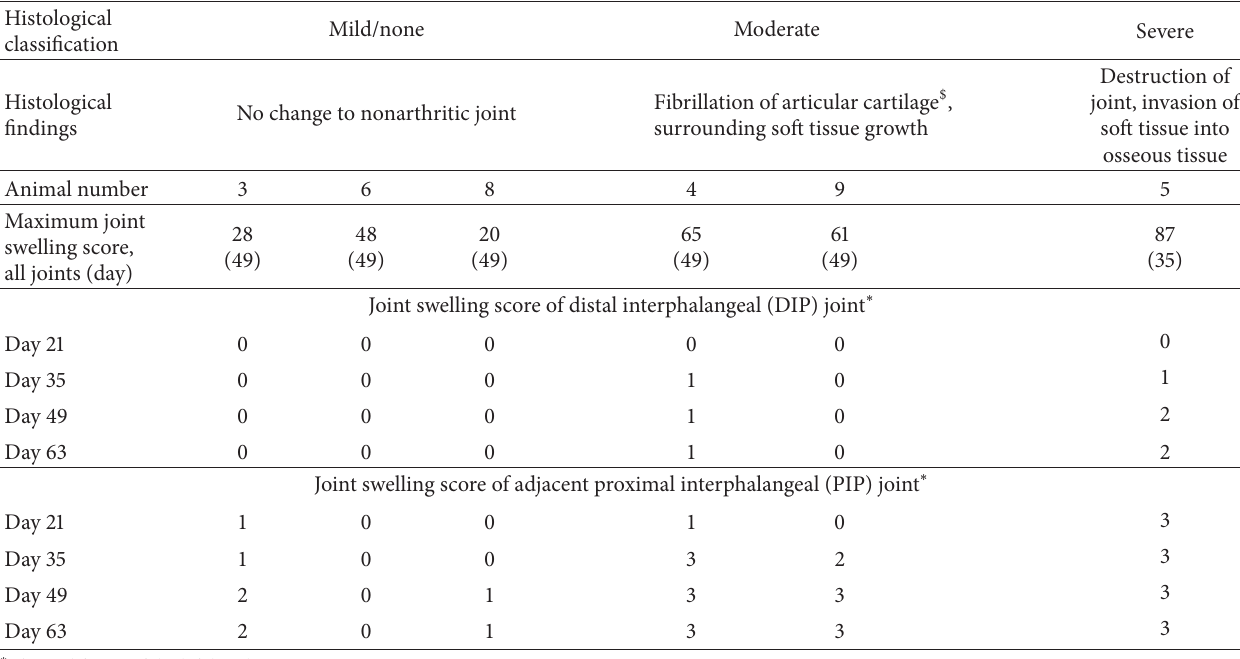
Table 2: Background data for joint samples.